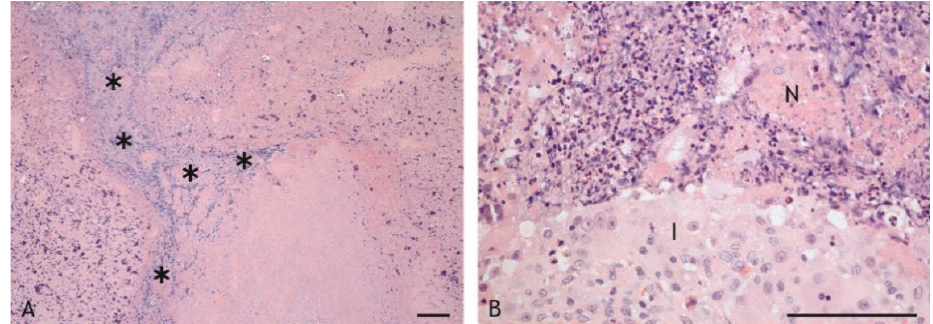
Figure 5. Nuclear debris ( A ) and neutrophils ( B ) in the caseous necrosis of a VPM1002-induced granuloma, goat 1. ( A ). Nuclear debris (*) extends in a wavy pattern throughout the necrosis. ( B ). Groups of neutrophils are multifocally present at the transition zone between inflammatory infiltrate (I) and necrosis (N). HE stain. Scale bars = 100 µ